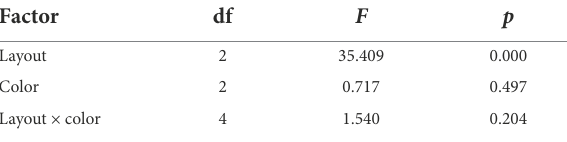
TABLE 4 Results of repeated measures ANOVA on visual search time.